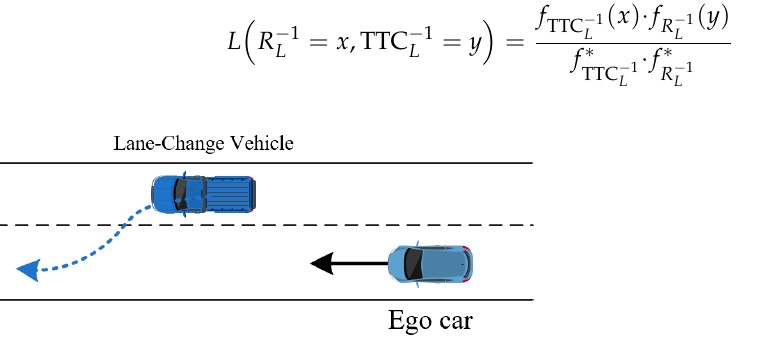
Figure 6. Lane-change scenario